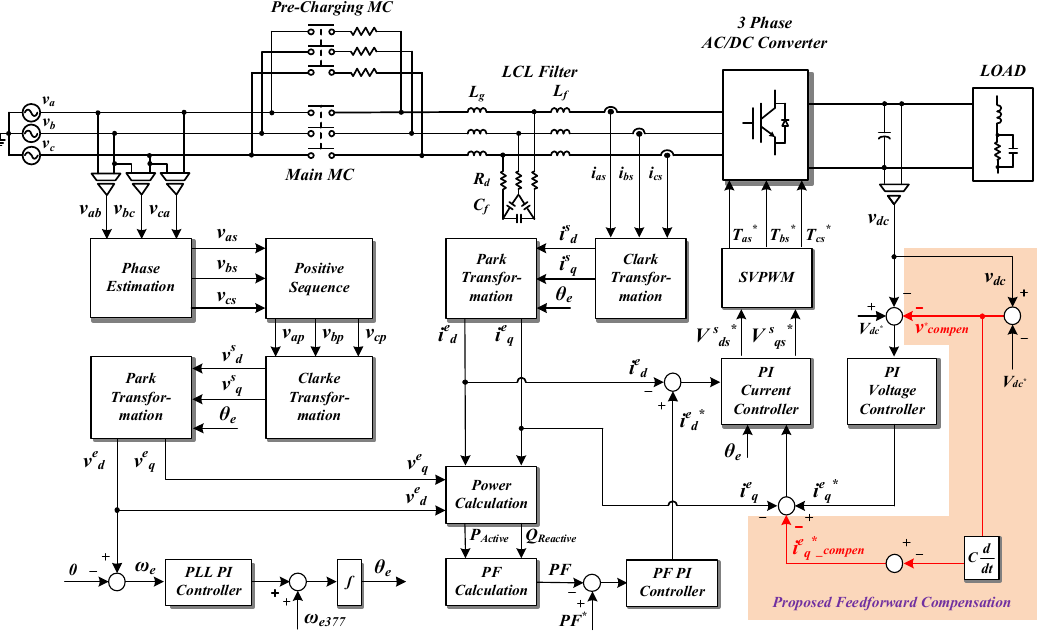
Figure 8. Overall control block diagram that applied the proposed compensation method of a module.